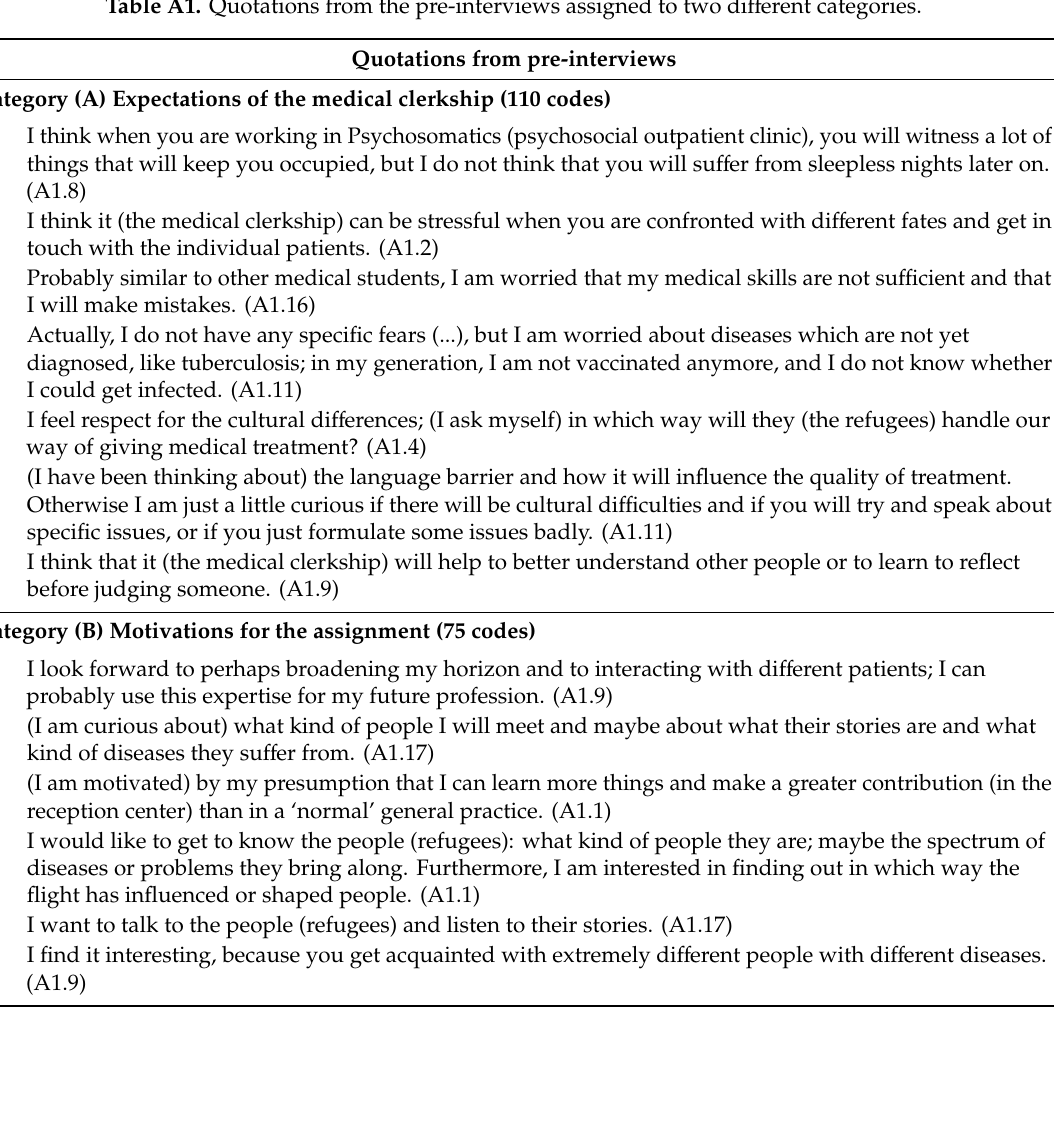
Table A1. Quotations from the pre-interviews assigned to two di ff erent